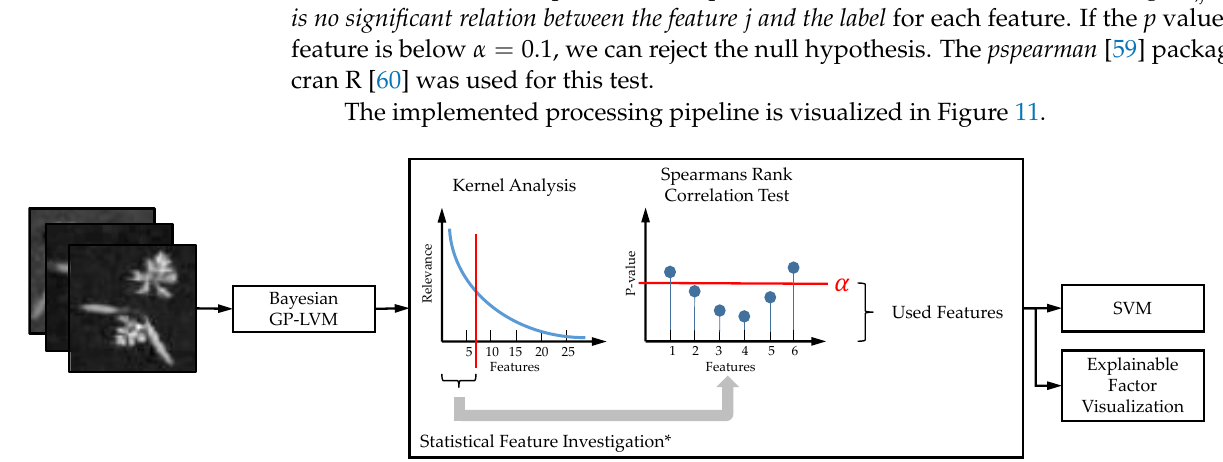
Figure 11. The implemented processing pipeline for B-GP-LVM based feature extraction. We initially use the kernels relevance values for feature pre-selection. Afterwards, we rely on Spearmans rank correlation test to identify the features with significant relation to the label. We extend the pipeline previously published in [29] by our statistical feature selection (see